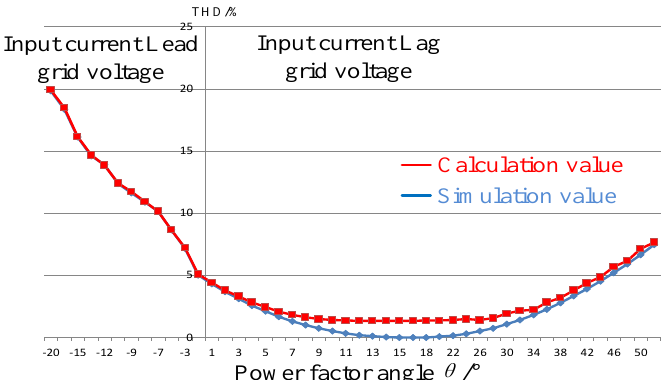
Figure 20. Relationship between theoretical THD and simulation THD with power factor angle θ .